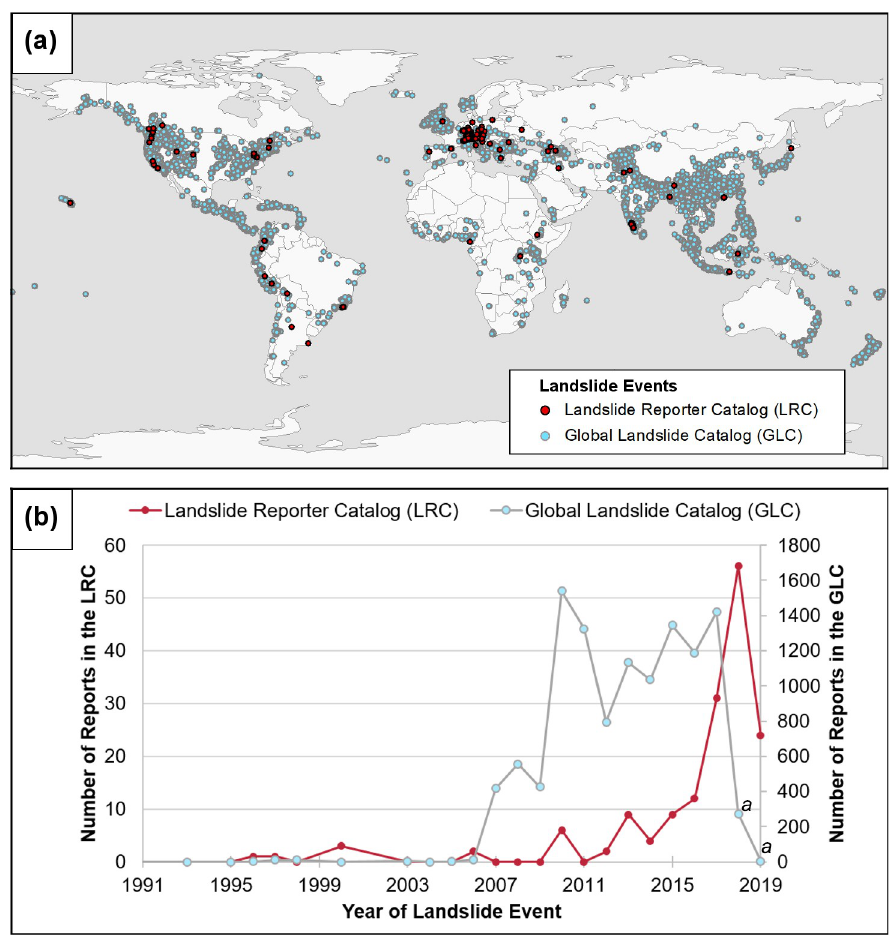
Fig 5. Distribution of landslide events by their location and time. (a) The map shows the spatial distribution of Landslide Reporter Catalog (LRC) events in red and Global Landslide Catalog (GLC) events in light blue. (b) The graph shows the temporal distribution of landslide events in the LRC (in red) in comparison with events in the GLC (in light blue). a The number of landslides in the GLC for 2018 and 2019 is low because we have not yet updated the catalog for this